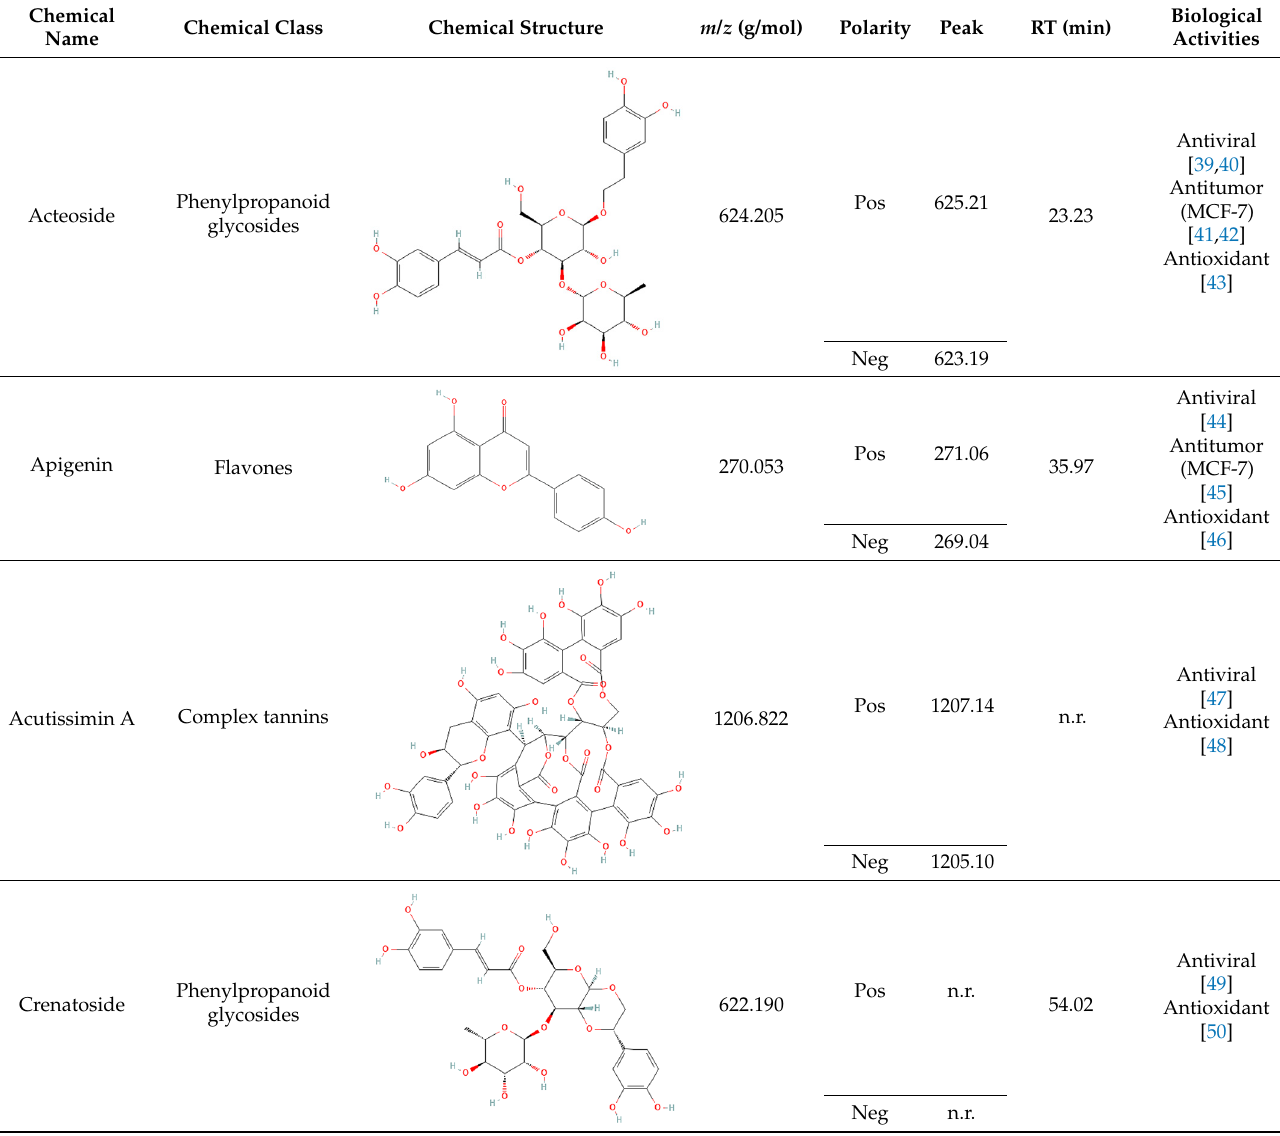
Table 2. Biological activities (antiviral, antitumor on the MCF-7 cell line, and antioxidant) of the chemical compounds identified in O. crenata leaf extract by UPLC-Ms/Ms.